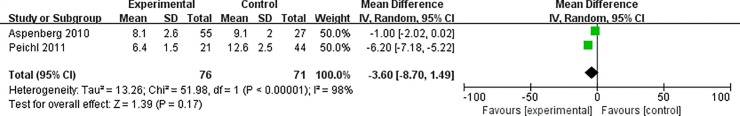
Forest plot for radiological fracture healing time.